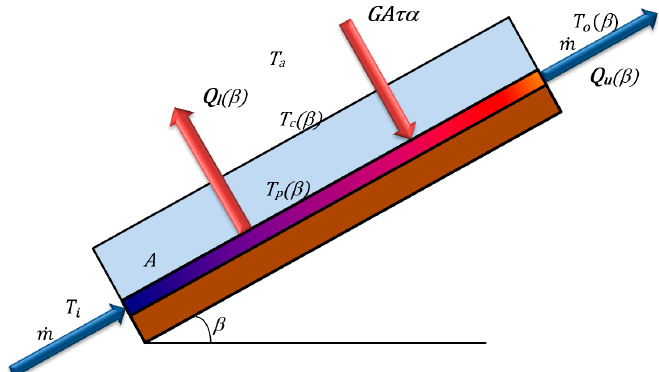
Table 1. Construction specifications of the solar collector.